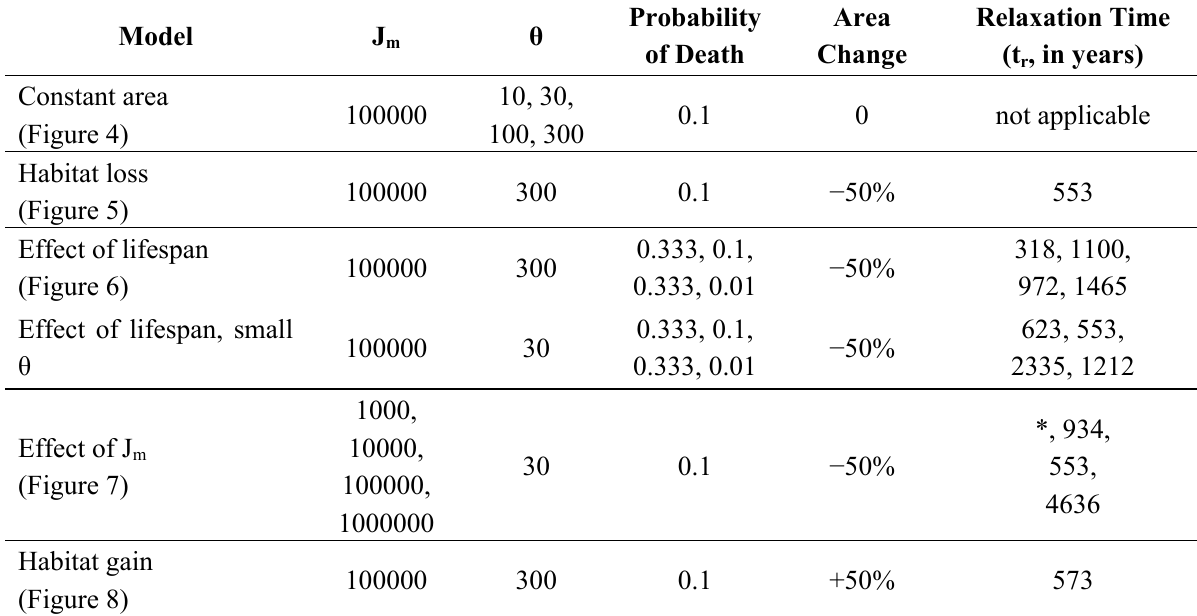
Table 1. Simulation parameters and calculated relaxation times.